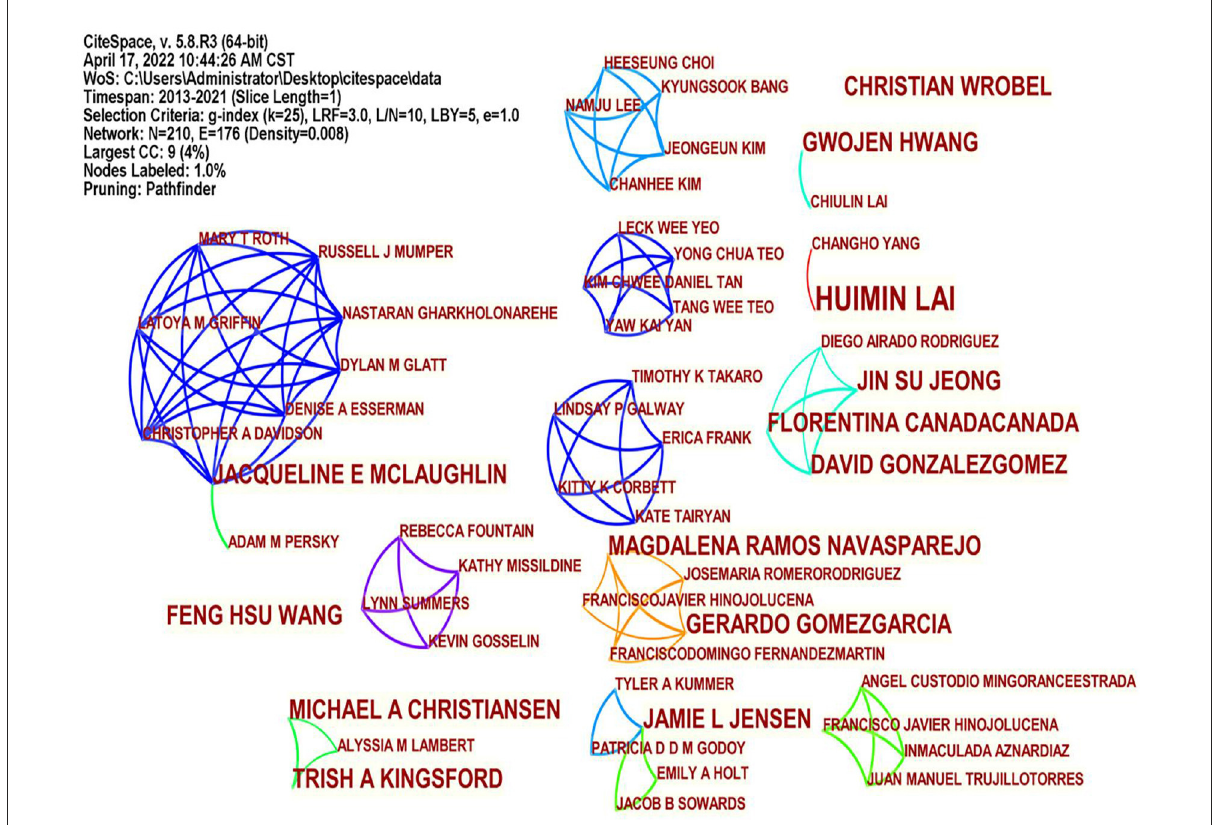
FIGURE3 Authors distribution mapping knowledge